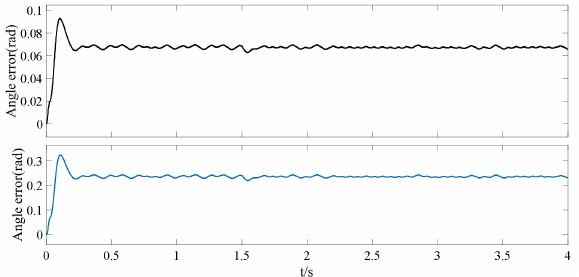
Figure 17. Waveform comparison of position angle error at 500 r/min.